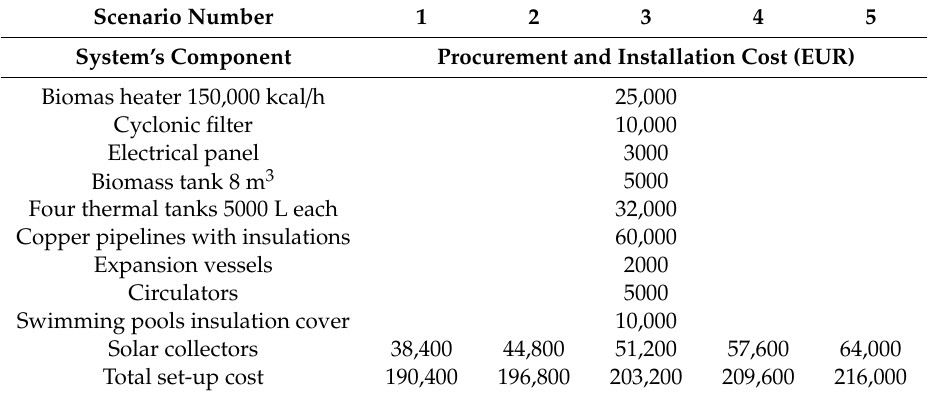
Table 6. Set-up cost analysis of the proposed solar-combi system, versus the investigated dimensioning scenarios.